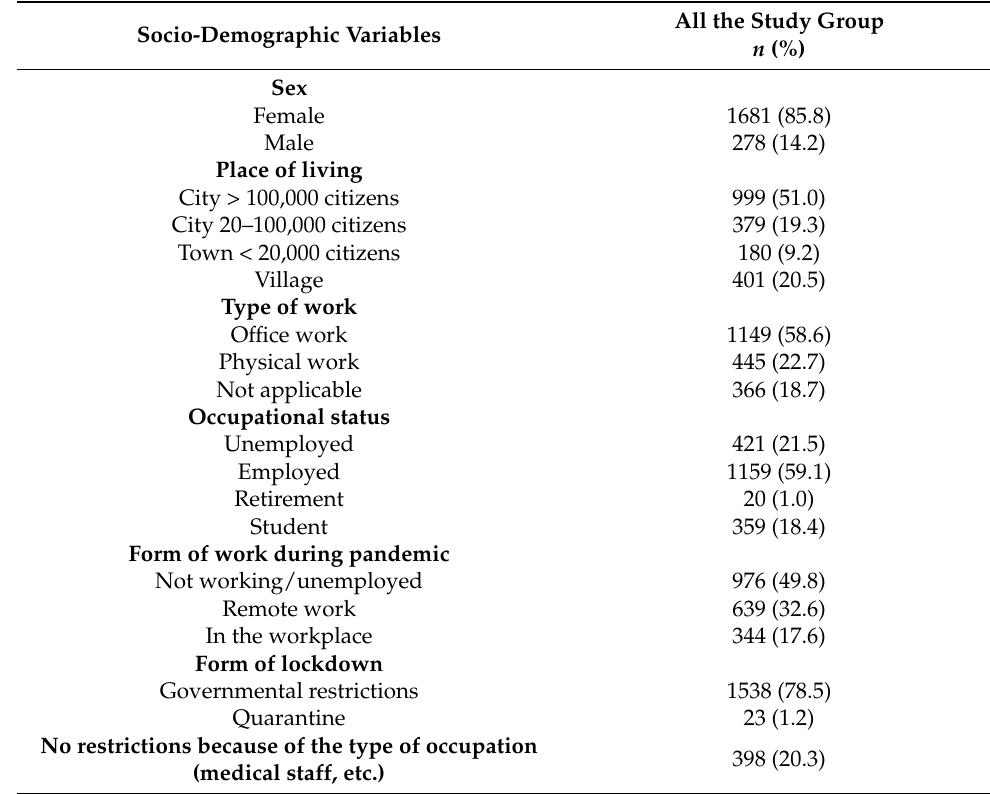
Table 1. The main socio-demographic variables characterizing the study group ( n = 1959).